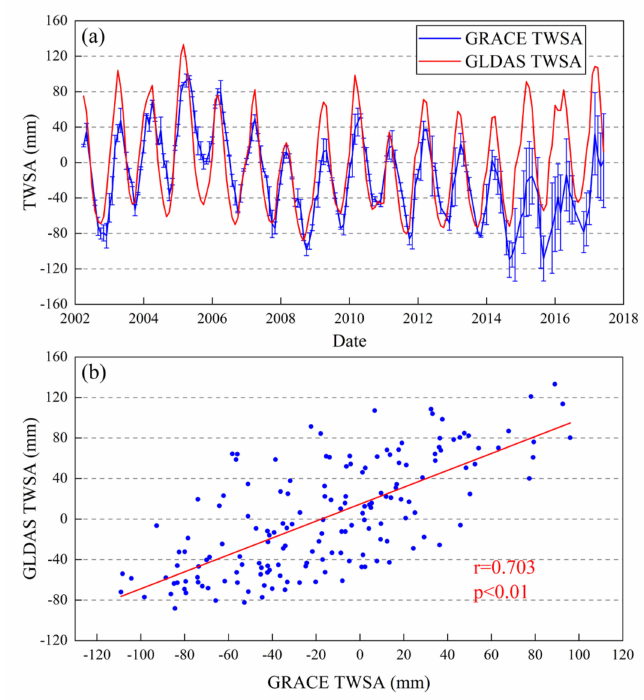
Figure 8. The comparison ( a ) and correlation ( b ) between GRACE TWSA and GLDAS TWSA in the Aral Sea Basin. The blue bars represent the data